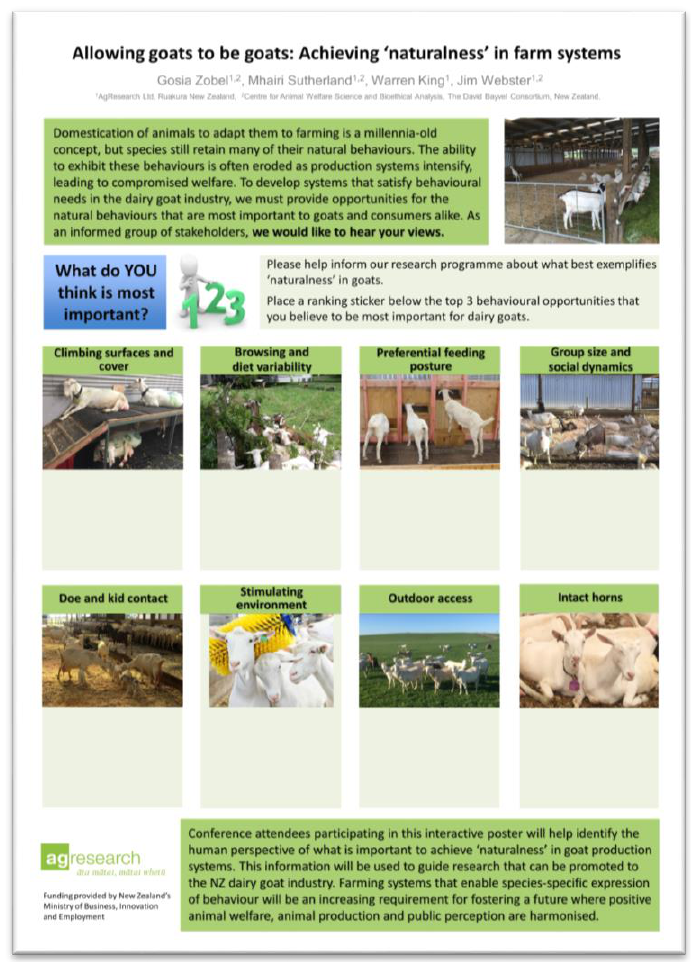
Figure 1. An interactive poster used to collect data from participants in various scenarios engaging stakeholders. Participants provided their opinion about which top three areas were important for promoting natural behavior in goats by placing numbered stickers in the light green boxes.